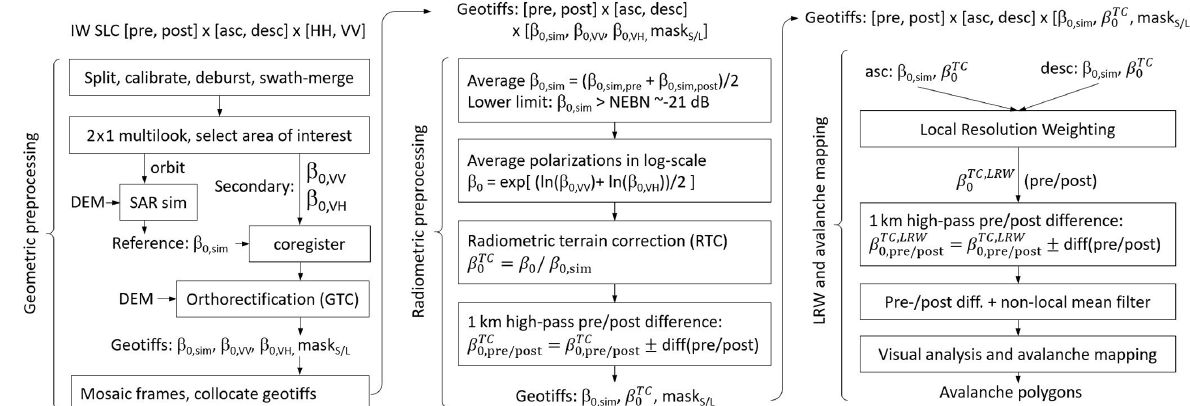
Figure A1. Flowchart illustrating the radar processing